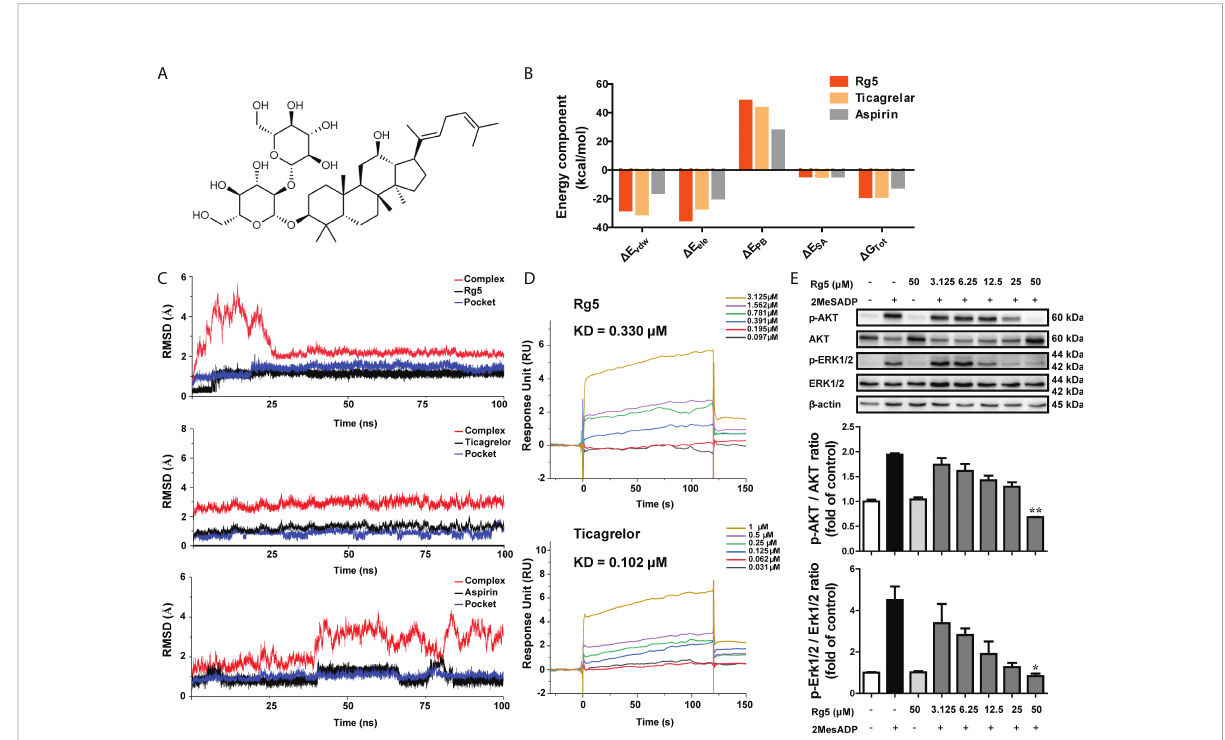
FIGURE 2 Interaction between Rg5 and P2RY 12 . (A) Chemical structure for Rg5. (B) Comparison of binding free energy between Rg5, Ticagrelor, and Aspirin binding to P2RY 12 . D E vdw , van der Waals energy; D E ele , electrostatic energy; D E PB , Poisson – Boltzmann energy; D E SA , nonpolar energy; D G Tot , total binding free energy. (C) Stability analysis of Rg5, Ticagrelor, and Aspirin binding to P2RY 12 . (D) SPR analyses of Rg5 and Ticagrelor binding to P2RY 12 . (E) Protein expression and phosphorylation levels of AKT (n = 3) and ERK (n = 3). All the data are shown as the mean ± SEM. * P < 0.05, ** P < 0.01 vs. 2MesADP